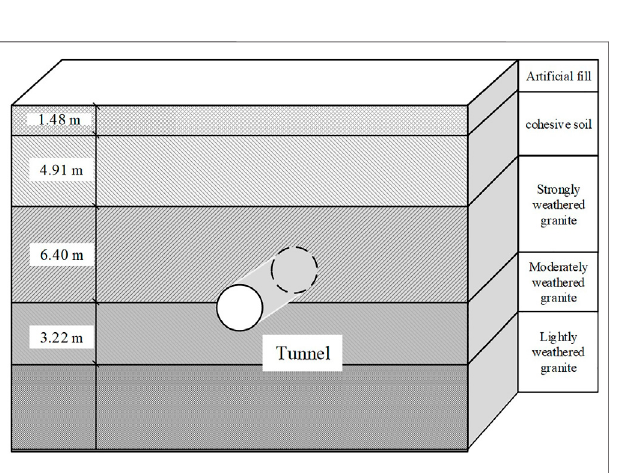
FIGURE 3 | Soil pro fi le and topology to